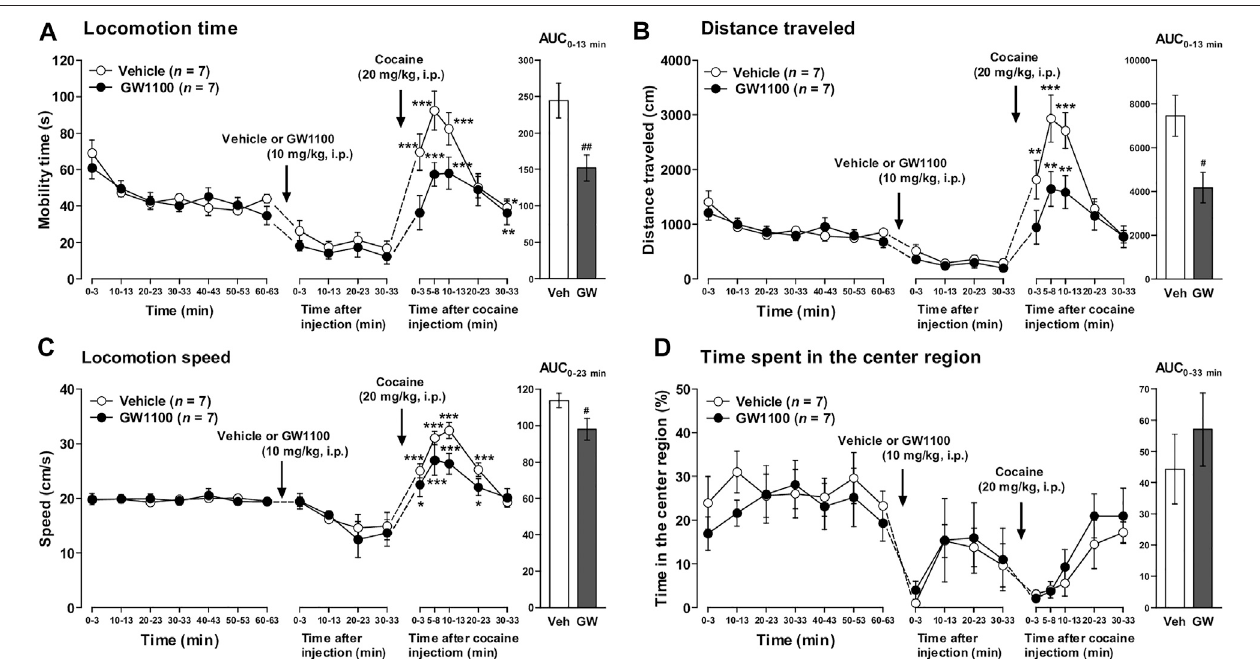
FIGURE6| Cocaine-evokedDAand5-HTreleasesinthestriatumofFFAR1+/+and − / − mice.Attime0 min.asinglei.p.injectionofcocaine(20 mg/kg)wasgiven. The fi gures show mean percentage changes from baseline DA (A) and 5-HT (B) values. * p < 0.05, *** p < 0.001 versus the basal values at time 0 min of the same genotype (one-way ANOVA followed by Dunnett ’ s post hoc test).